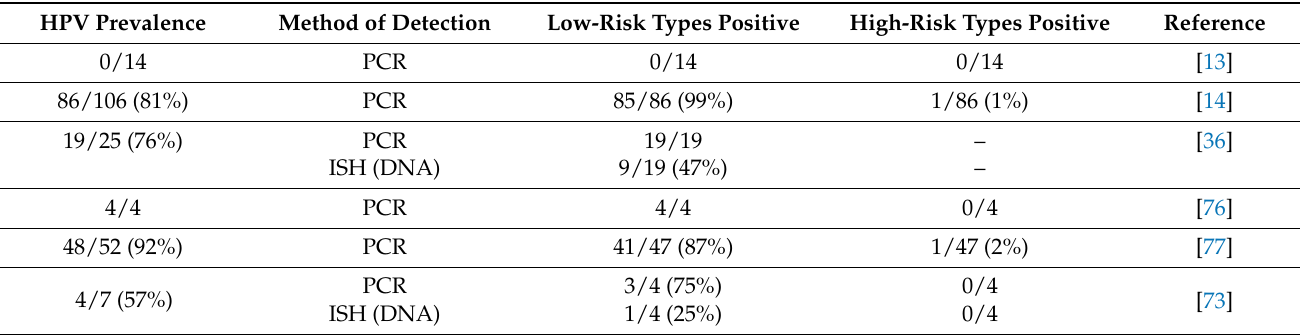
Table 3. HPV Detection in Conjunctival Papillomas Reported in the